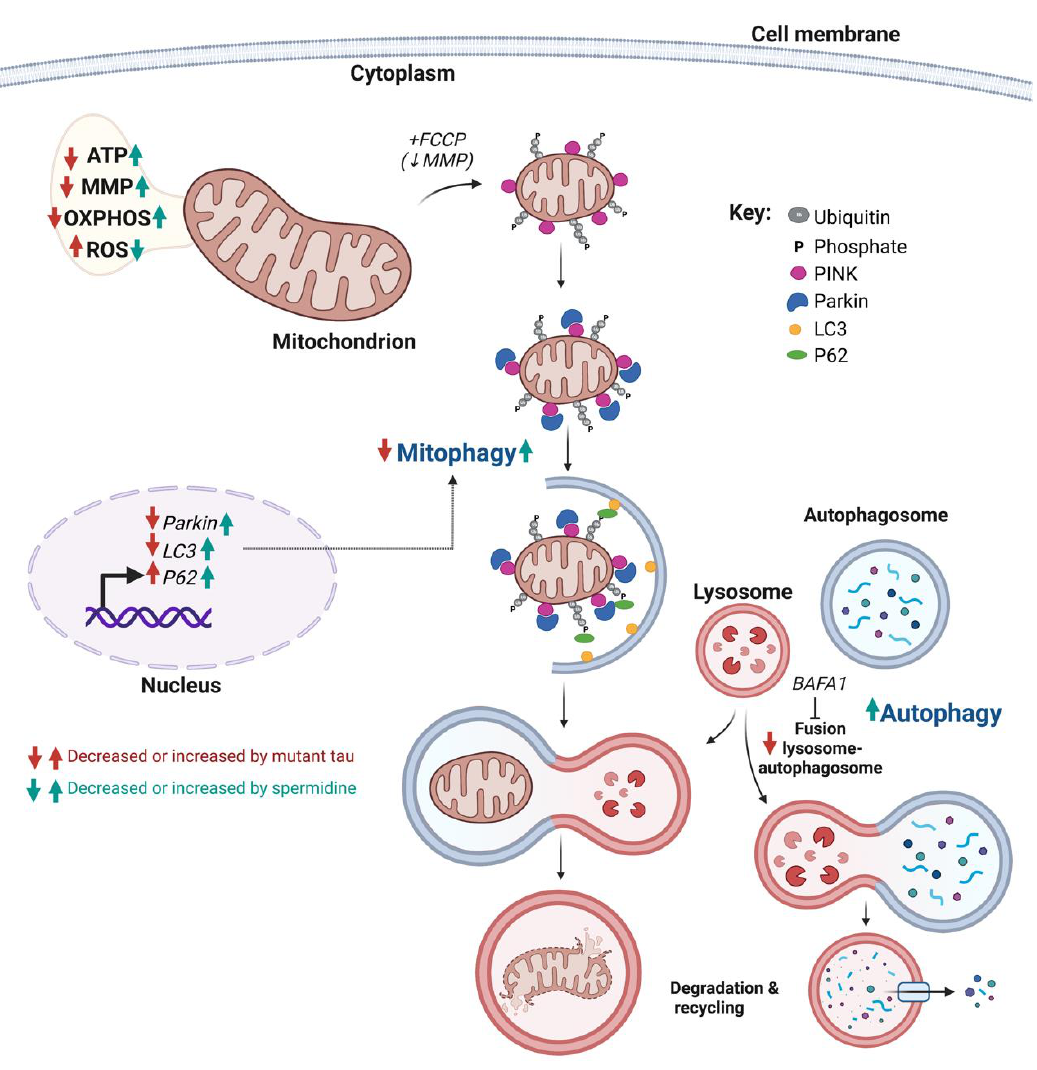
Figure 6. Schematic representation of the effects of abnormal tau protein and spermidine on mito- chondrial function and autophagy. P301L mutant tau protein impairs mitochondrial bioenergetics, leading to decreased mitochondrial respiration, mitochondrial membrane potential (MMP) and ATP production, as well as an increase in reactive oxygen species (ROS) level. Spermidine seems to counteract the effects of abnormal tau on these parameters. P301L mutant tau protein also impairs autophagy (possibly by inhibiting the fusion between lysosomes and autophagosomes) as well as mitophagy. These effects may be, at least in part, due to the abnormal tau-induced dysregulation of genes involved in mitophagy/autophagy. Spermidine improves these processes in mutant tau- expressing cells and increases the expression of genes involved in mitophagy/autophagy. PINK1: PTEN-induced putative kinase 1; PARK2: Parkin; LC3: microtubule-associated protein 1A/1B-light chain 3; P62: Sequestosome-1. Created with